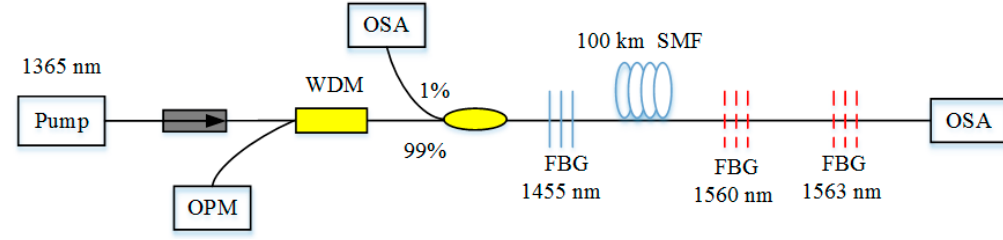
Figure 17. Scheme of RFL using FBG as a sensing element.